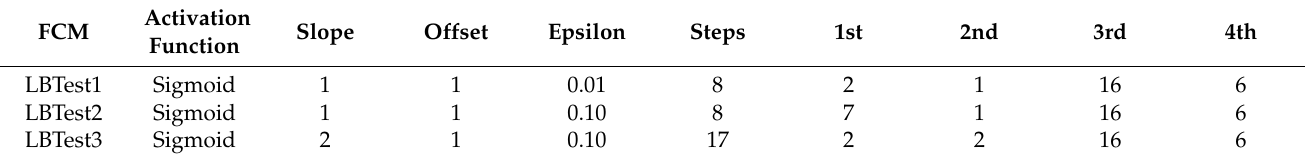
Table 8. Mapping test with a 2-way connection (LB) between concepts and no autogenerated weights.